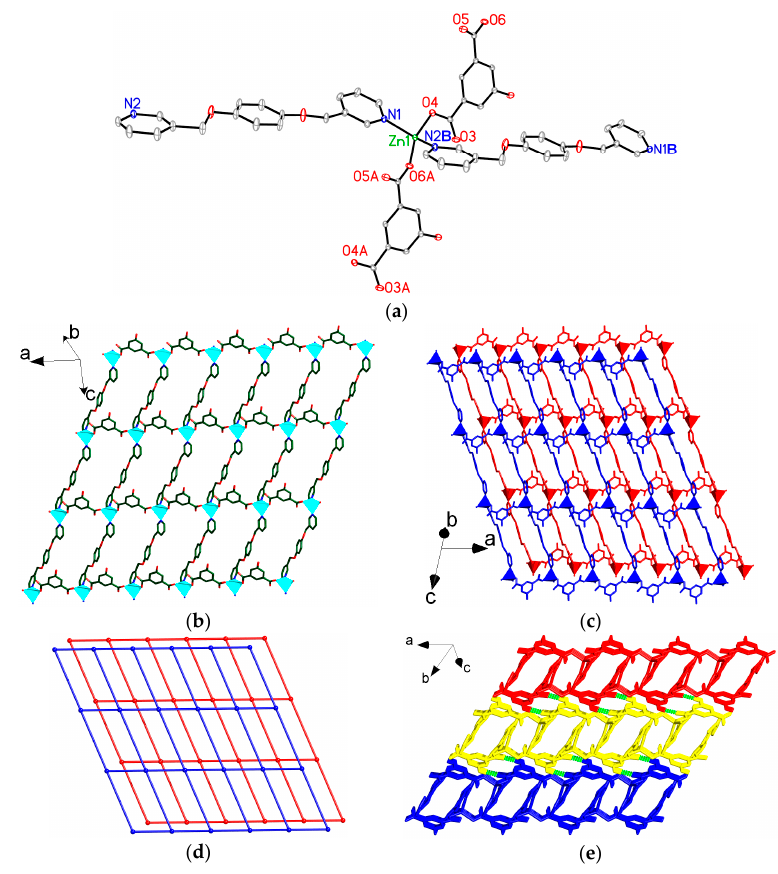
Figure 3. ( a ) View of the coordination environments of Zn center in 2 with labeling schemes.